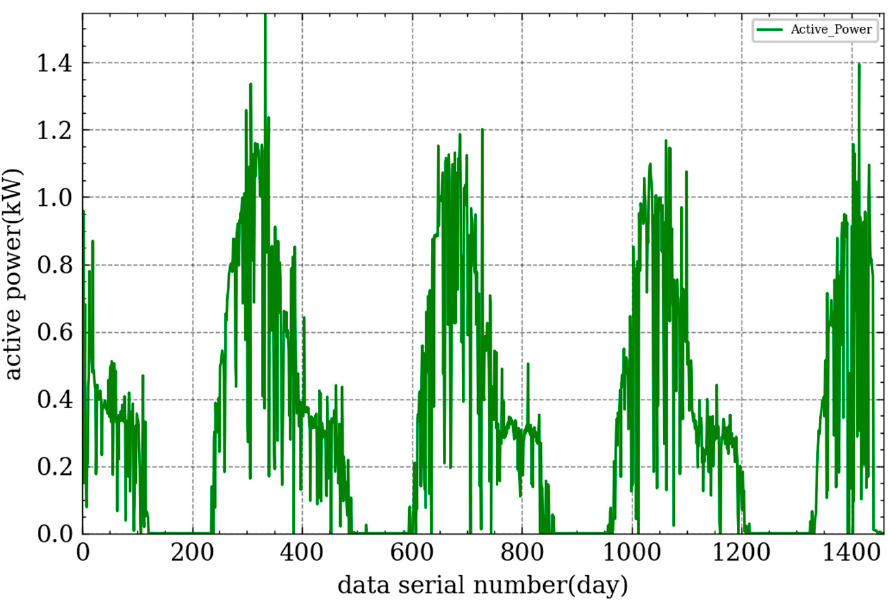
Figure 2. Graph of 8:30 data for 4 continuous years.